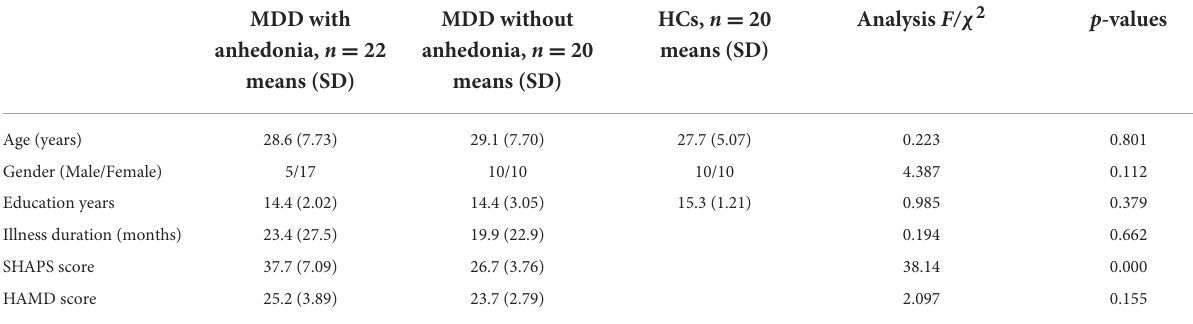
TABLE 1 Demographic and clinical characteristics for all subjects ( n = 62).